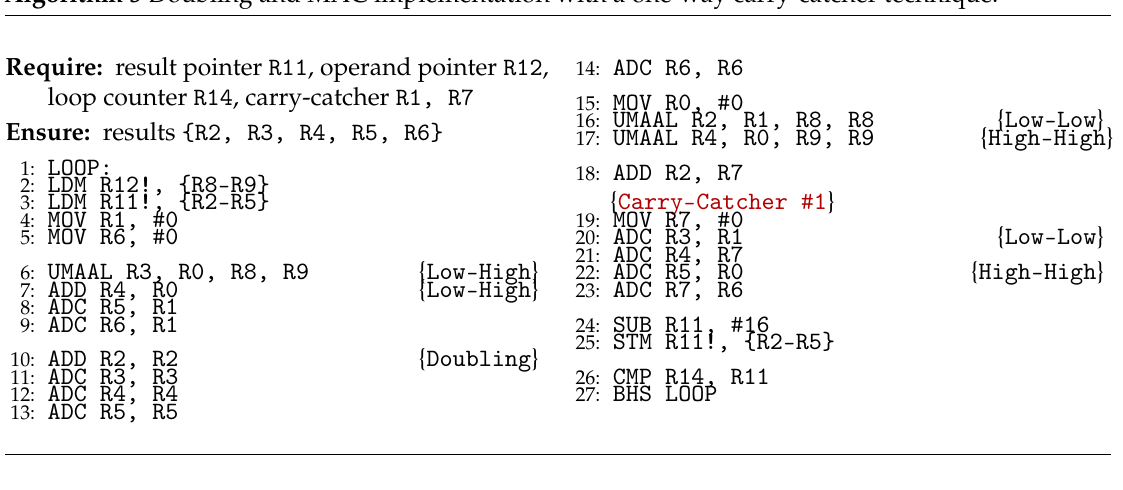
Algorithm 3 Doubling and MAC implementation with a one-way carry-catcher technique.